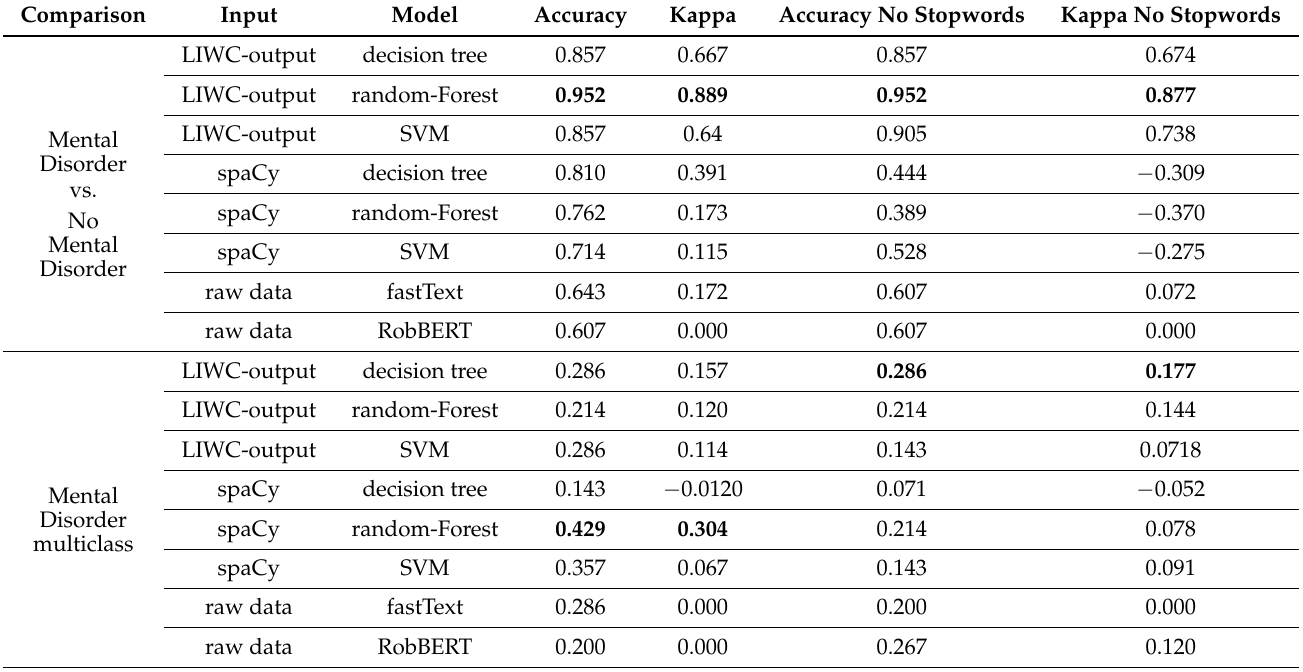
Table 3. Accuracy and Cohen’s Kappa for the model predictions (with and without stop